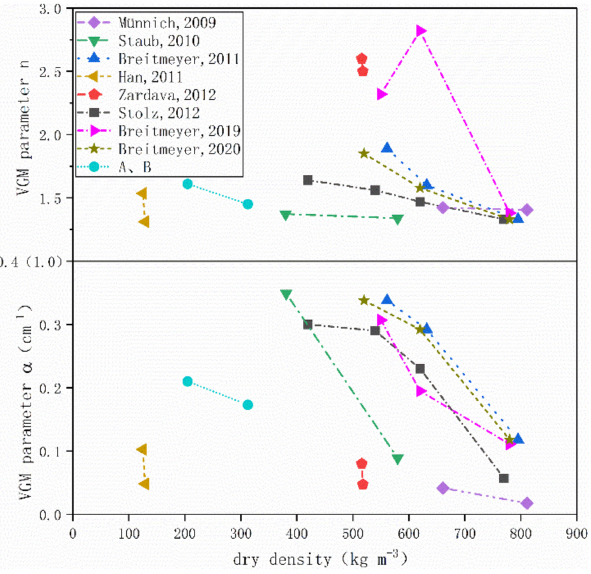
Figure 7. Relationship between VGM model parameters α , n and dry density. Table 4. Hydraulic parameters of waste DPeM model with different properties ( ± values are 95% confidence interval).